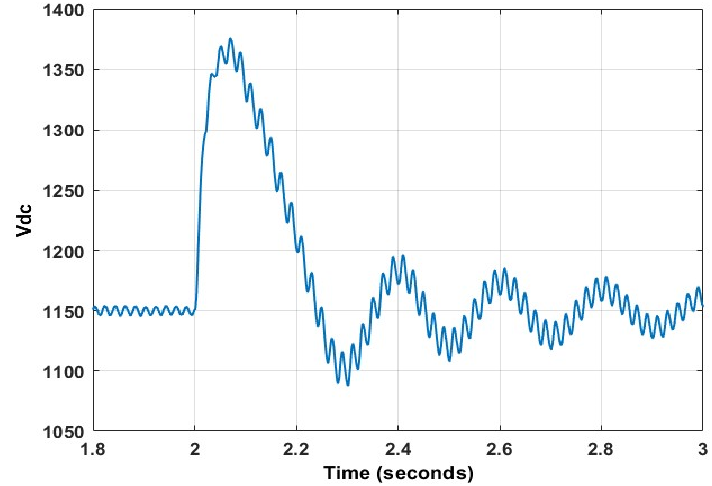
Figure 30. DC voltage transient using LQR at 70% dip.